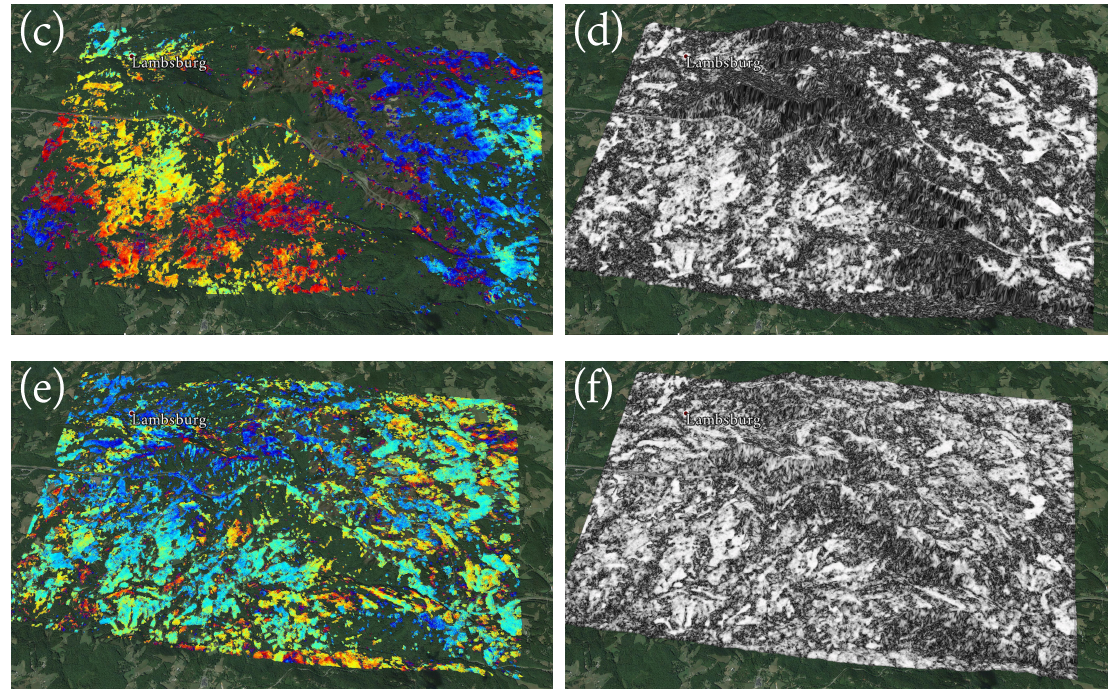
Figure 10. ( a , b ): Interferogram and corresponding coherence map between 2015/12/03 and 2015/12/11 (8 days), normal baseline: − 55 m, ascending, 32 ◦ incidence angle; ( c , d ): Interferogram and corresponding coherence map between 2015/11/13 and 2015/11/21 (8 days), normal baseline: − 384 m, descending, 34 ◦ incidence angle; ( e , f ): Interferogram and corresponding coherence map between 2015/11/28 and 2015/12/06 (8 days), normal baseline: 432 m, descending, 56 ◦ incidence